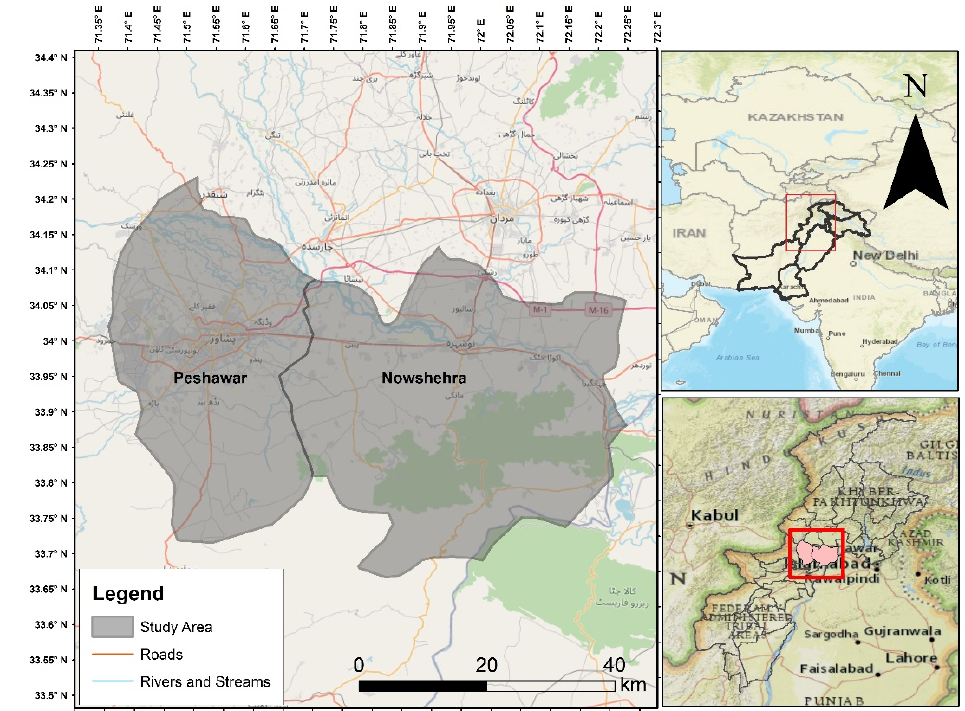
Figure 1. Maps depicting the study areas in northwestern